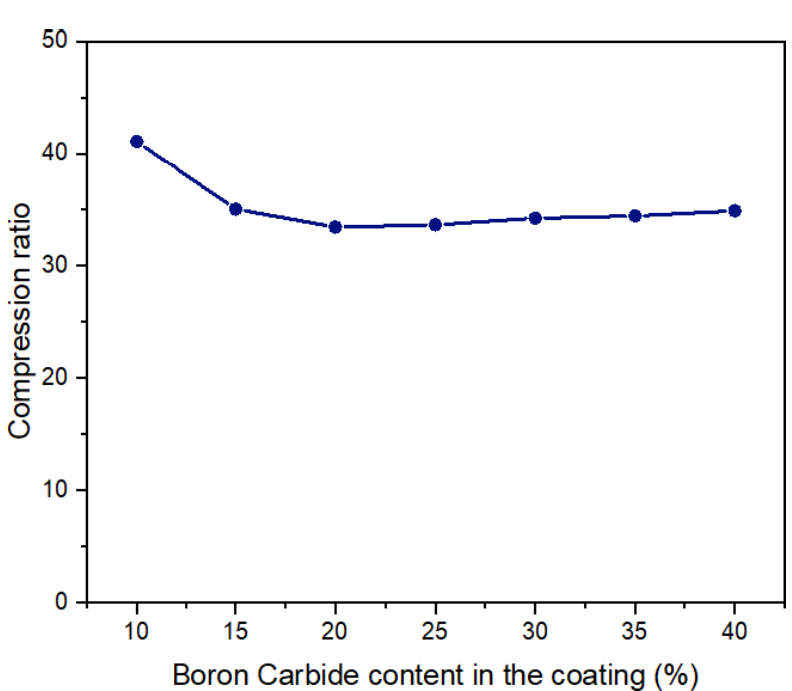
Figure 10. The matrix for compression ratios and various coatings of B 4 C /Ni63.